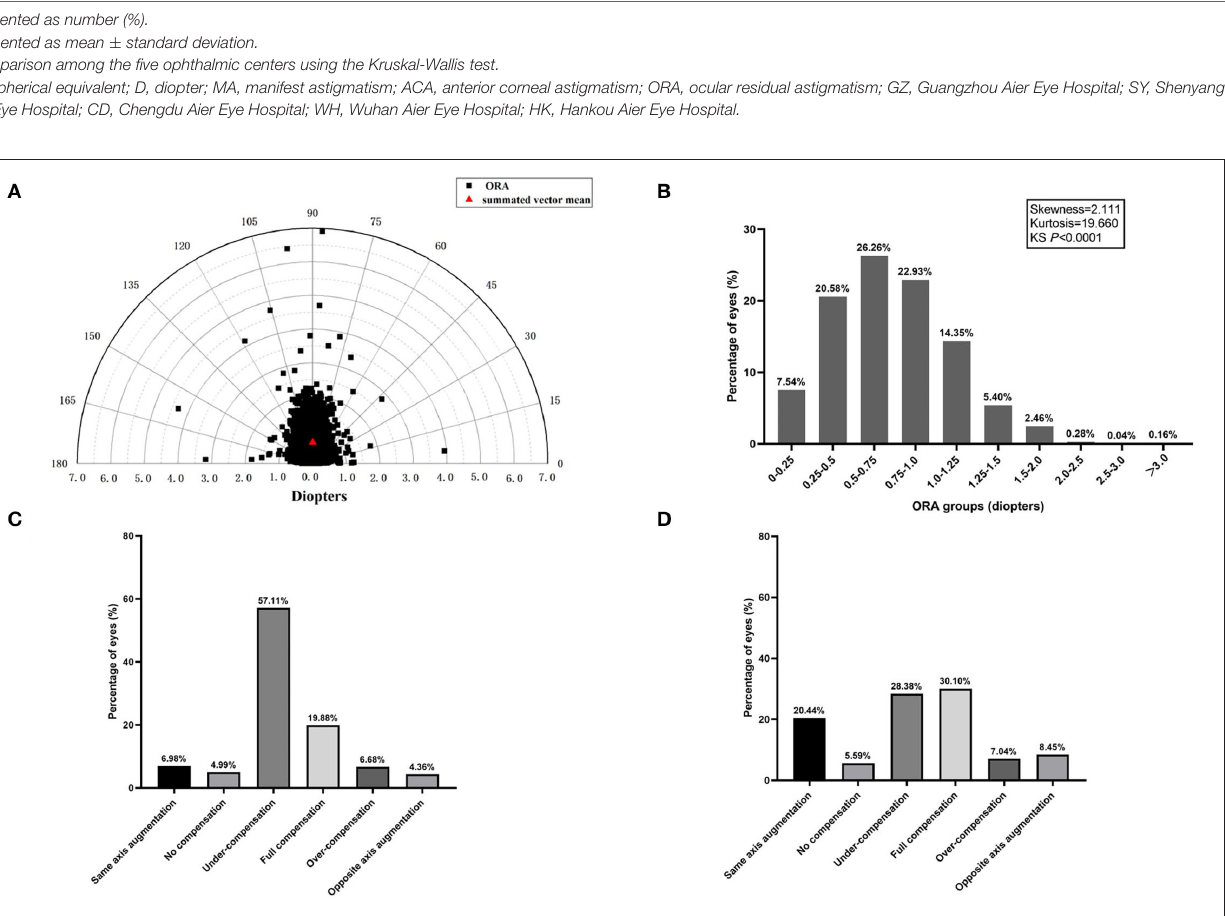
Frontiers in Medicine |